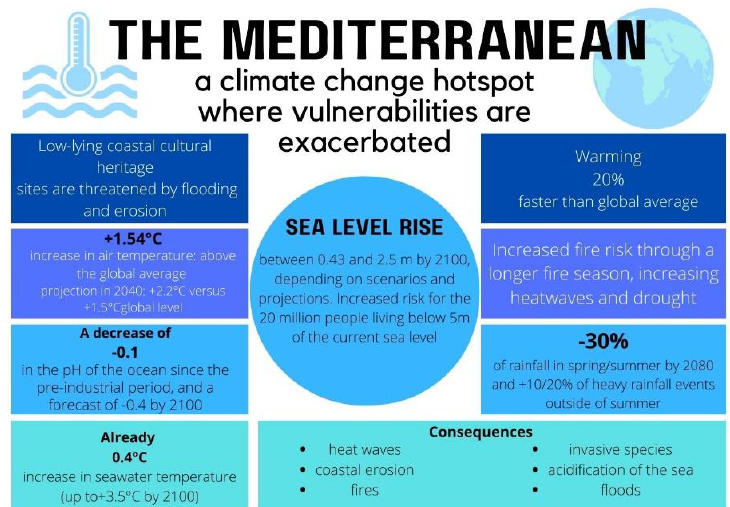
Figure 6. Climate change in the Mediterranean. Source: [39].